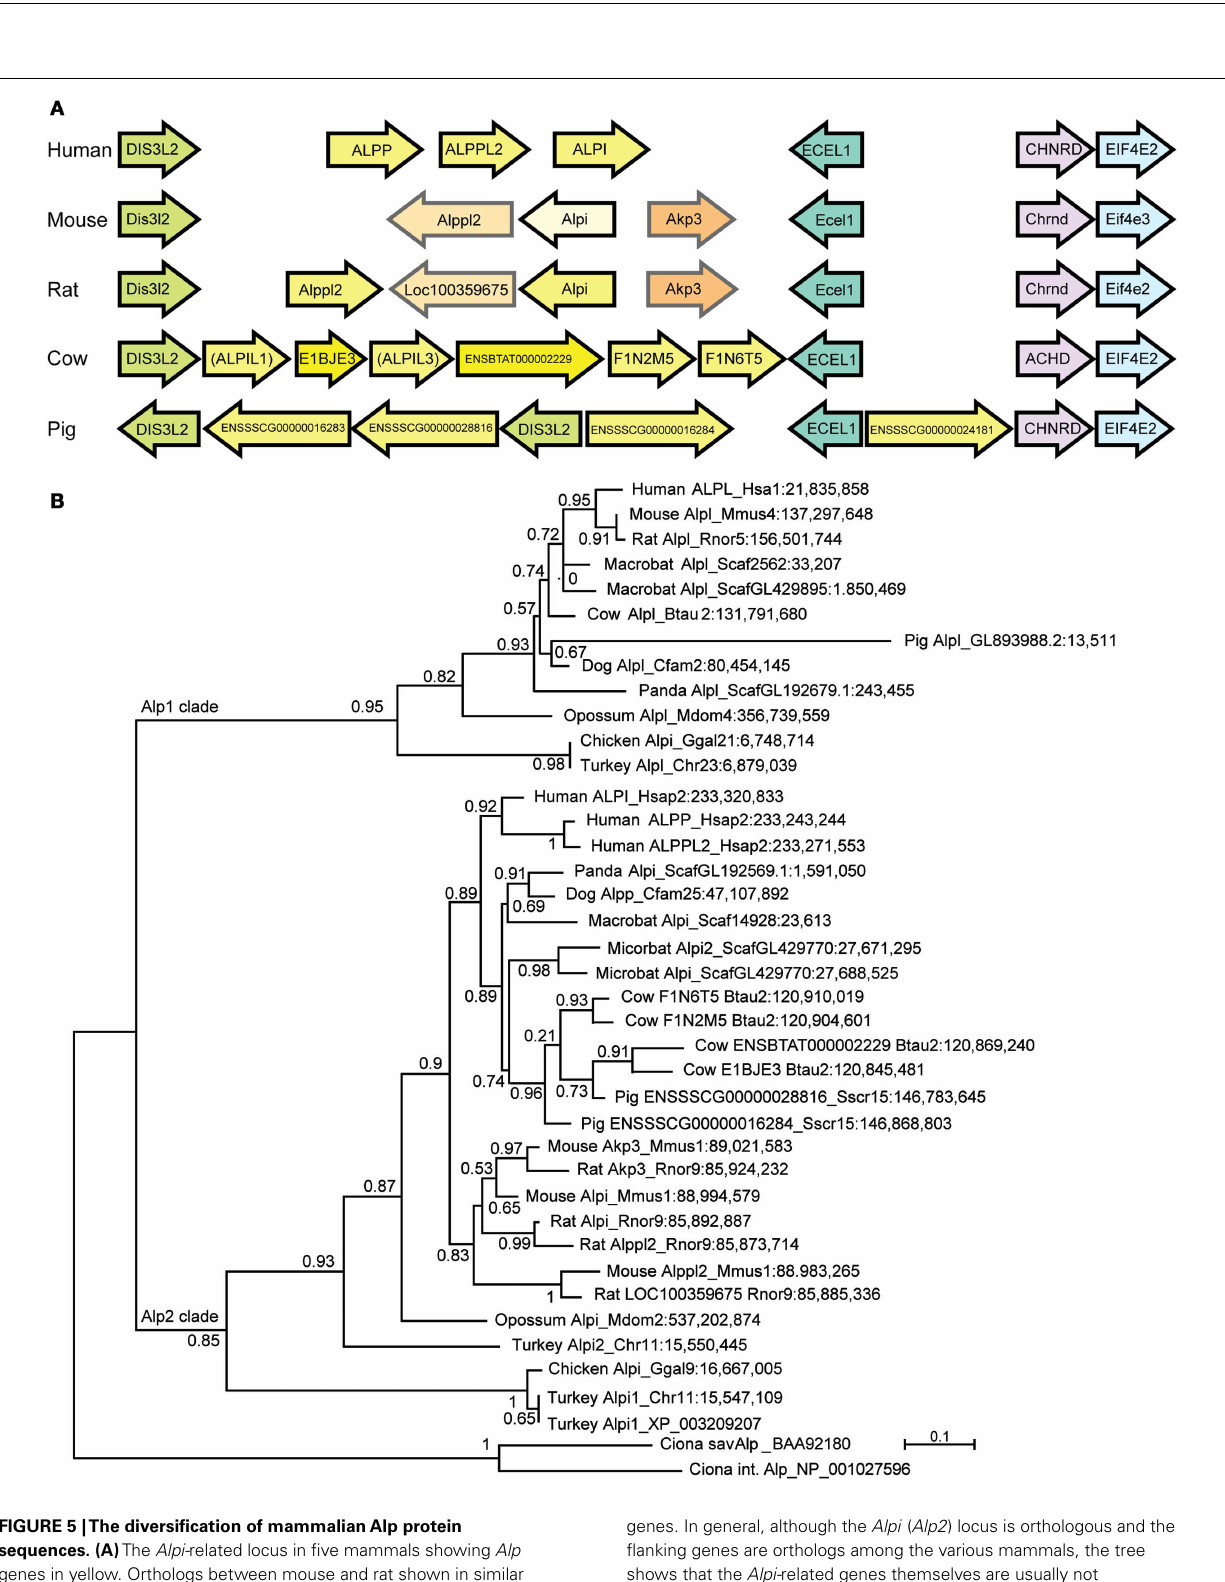
genes. In general, although the Alpi ( Alp2 ) locus is orthologous and the flanking genes are orthologs among the various mammals, the tree shows that the Alpi- related genes themselves are usually not one-to-one